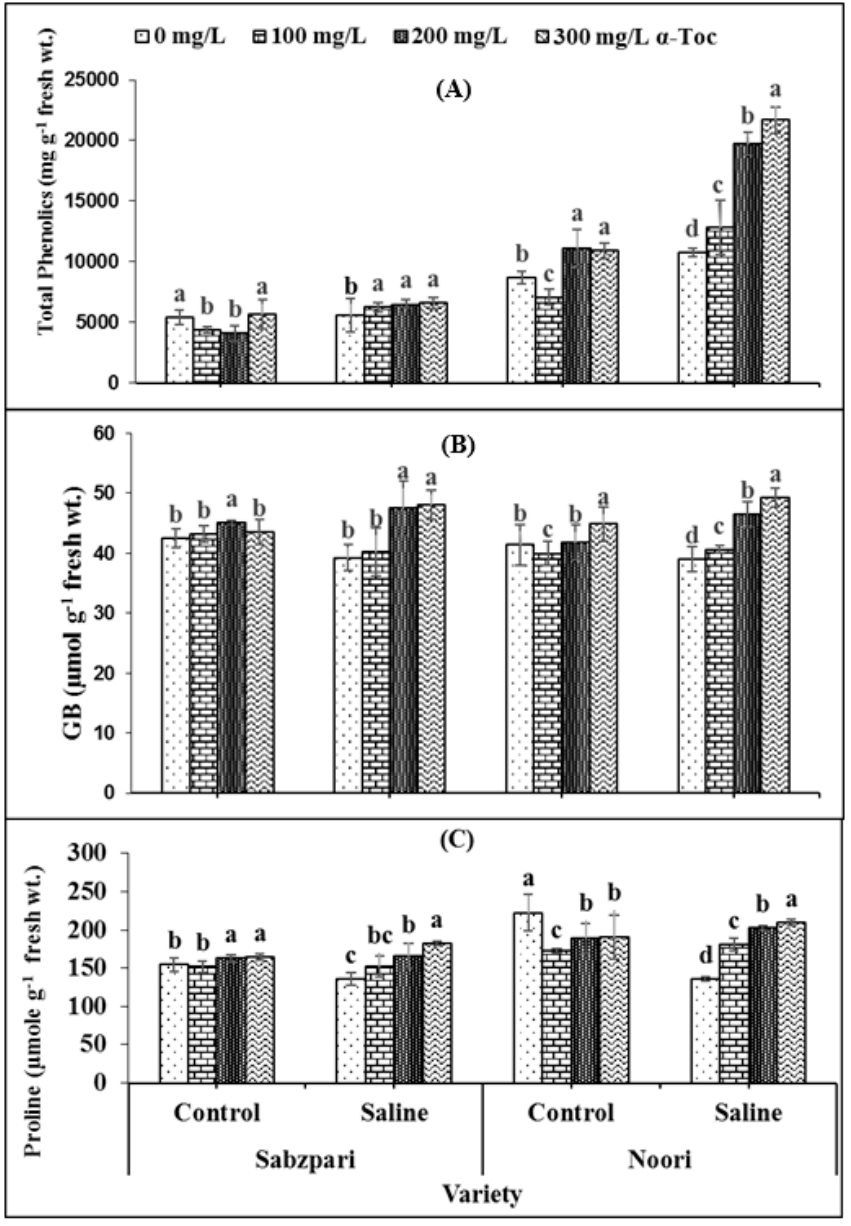
Figure 4. Effect of different levels of α -Toc under saline and non-saline conditions on ( A ) total phenolics ( B ) glycinebetaine (GB), and ( C ) proline content of okra varieties. Values represent means ± S.D. Significant differences among row spacing were measured by the least significant difference (LSD) at p > 0.05 and indicated by different letters. S.D. stands for standard